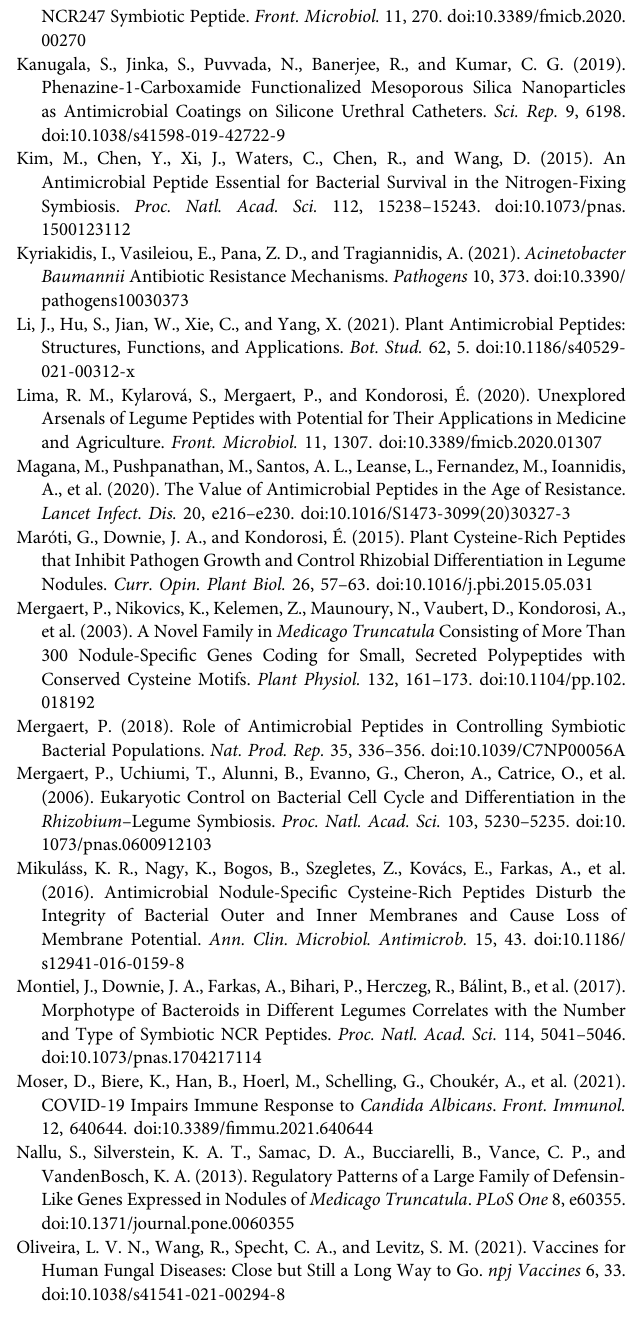
Supplementary Figure S1 | Physicochemical properties of active and inactive NCRs calculated by DBAASP v3 (normalized hydrophobic moment, normalized hydrophobicity, penetration depth, tilt angle, disordered conformation propensity, linear moment, propensity to in vitro aggregation, angle subtended by the hydrophobic residues, amphiphilicity index, propensity to PPII coil) and PepCalc. com (net charge, pI). Active NCRs have antimicrobial activity against at least one pathogen.Graphsrepresentmean±SD.*: p < 0.05,****: p < 0.0001,asdetermined by t -test. Supplementary Figure S2 | Hemolytic activity of NCRs. Human red blood cells were treated with different NCRs (0.4 – 100 µM). Hemolysis of red blood cells with 0.5% Triton-X represents 100% hemolytic